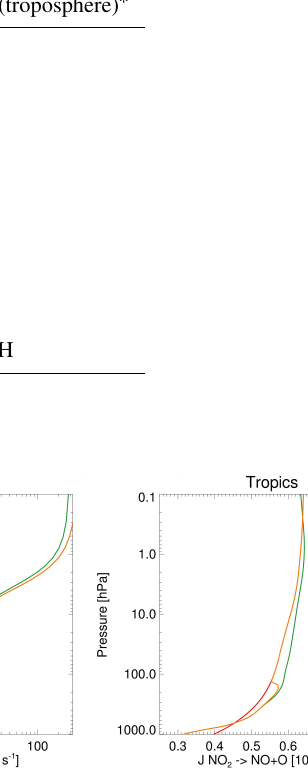
Table 4. Selection of photolytic reactions that are merged between the troposphere and stratosphere. The reaction product O 2 is not shown. Name